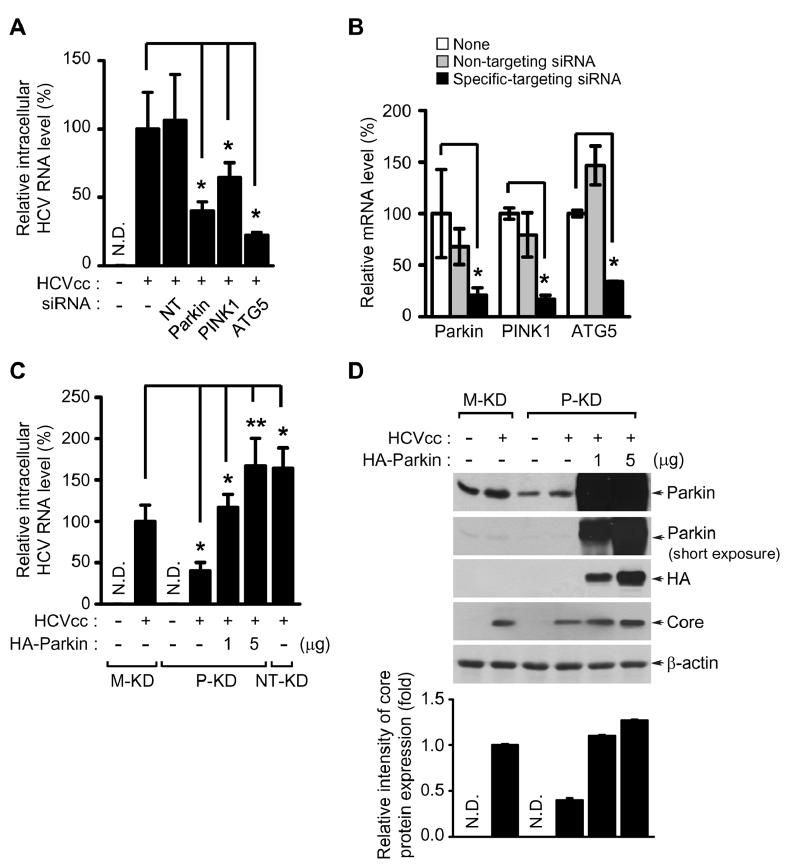
Figure 6. Parkin and PINK1 affects HCV replication. ( A and B ) Inhibitory effect of Parkin, PINKI, and ATG5 silencing on HCV replication. Huh7 cells transfected with Non-Targeting (NT) or gene-specific siRNA pools targeting Parkin, PINK1, and ATG5 genes, respectively, were infected with HCVcc. At day 3 post-infection, the levels of HCV RNA ( A ) and targeted gene mRNA ( B ) were analyzed by real-time qRT-PCR, as described in Materials and Methods (mean 6 SD; n=3; * p , 0.01). GAPDH was used to normalize changes in Parkin, PINK1, and ATG5 gene expression. ( C and D ) Rescue of HCV RNA replication by Parkin overexpression. Huh7 cells stably expressing mock vector (M-KD), Non-target-shRNA (NT-KD), and Parkin-shRNA (P-KD), respectively, were infected with HCVcc. P-KD cells were further transfected with two different concentration of the plasmid DNA encoding wild-type Parkin for 2 days before harvest. At 3 days post-infection, intracellular HCV RNA levels were analyzed by real-time qRT-PCR. GAPDH was used to normalize changes in HCV RNA expression ( C ) (mean 6 SD; n=3; * p , 0.01, ** p , 0.05). ( D ) The expression levels of Parkin and HCV core protein were analyzed by immunoblotting with anti-Parkin and HCV core antibodies. Ectopic expression level of HA-tagged wild-type Parkin was detected by immunoblotting with anti-HA antibody. b -actin was used as an internal loading control. P values were calculated by using an unpaired Student’s t- test. The relative intensity of HCV core expression normalized to b -actin was analyzed by ImageJ.